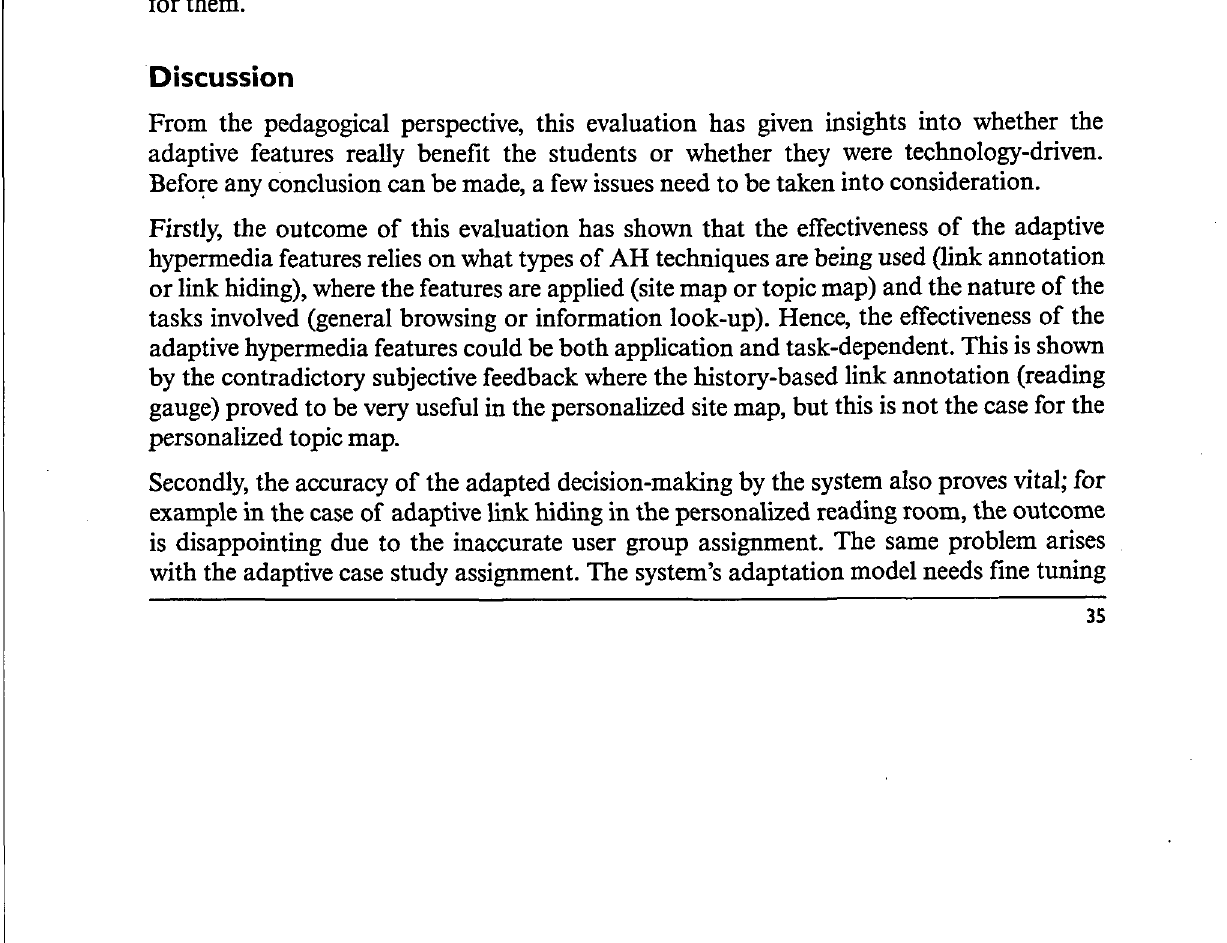
Figure 14: The analysis of allocation fitness from the system adaptation decision-making in assigning case